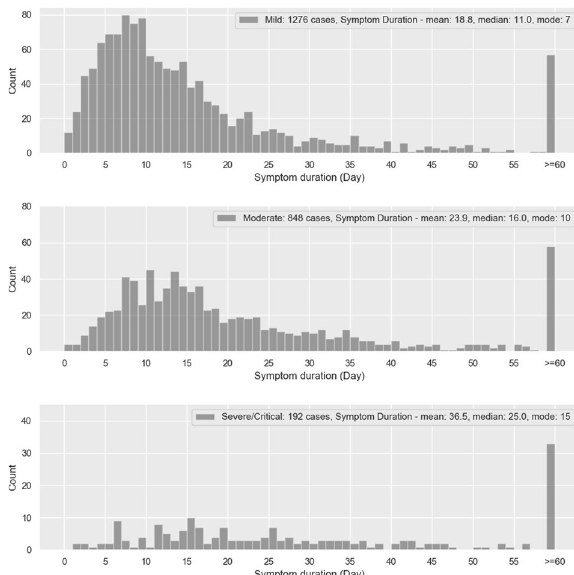
Fig. 5 Duration of symptoms. Distribution of symptom duration for mild, moderate, and severe/critical cases. The median symptom duration is 11 days for mild cases, 16 days for moderate cases, and 25 days for severe/critical cases. For mild, moderate, and severe/ critical cases, the fraction of participants with duration of symptoms exceeding 60 days is found to be 3.9%, 6.4%, and 16%,